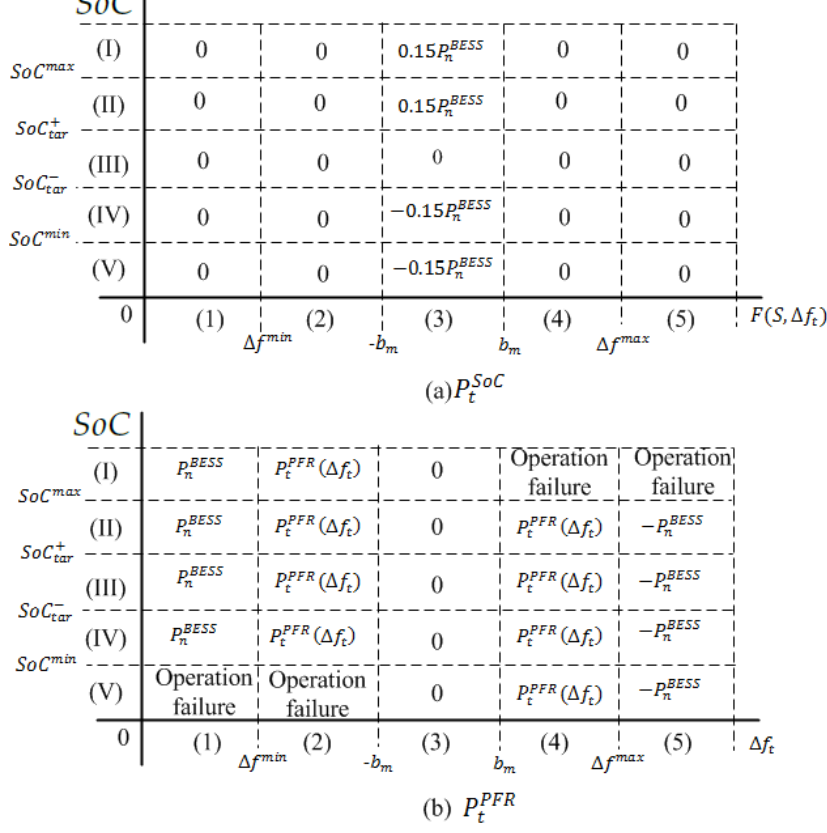
Figure 2. BESS output power as function of SoC and grid frequency. ( a ) Power required for SoC regulation; ( b ) Power required for PFR